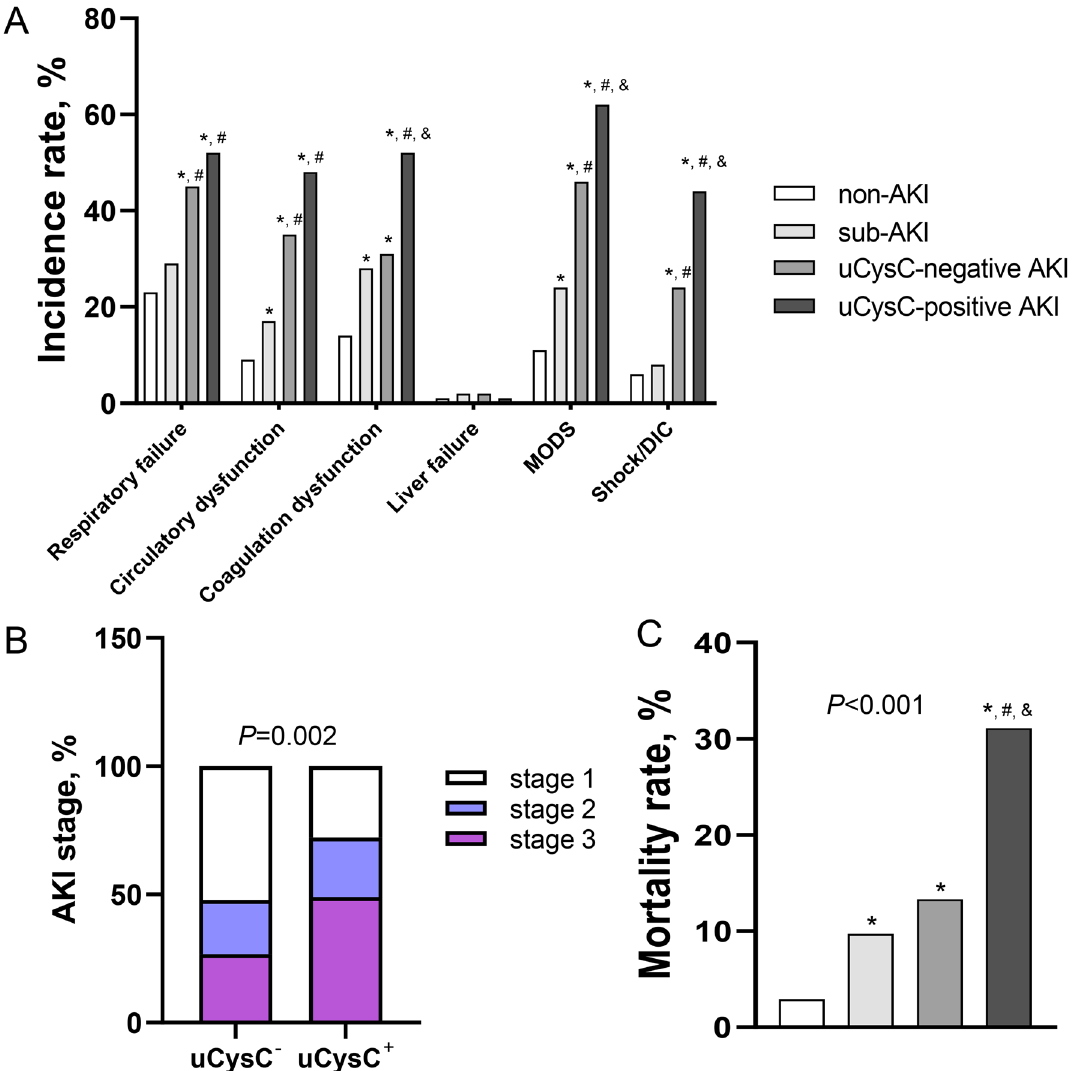
0.889), multi-organ dysfunction syndrome (MODS) ( P < 0.001), and shock/disseminated intravascular coagulation = (DIC) ( P < 0.001); B AKI stage between AKI substage A and B; C 30-day pediatric intensive care unit (PICU) mortality. AKI, acute kidney injury; sub-AKI, subclinical AKI; uCr, urinary creatinine; uCysC, urinary cystatin C. * P < 0.05, vs. non-AKI; # P < 0.05, vs. sub-AKI; & P < 0.05, vs. AKI substage